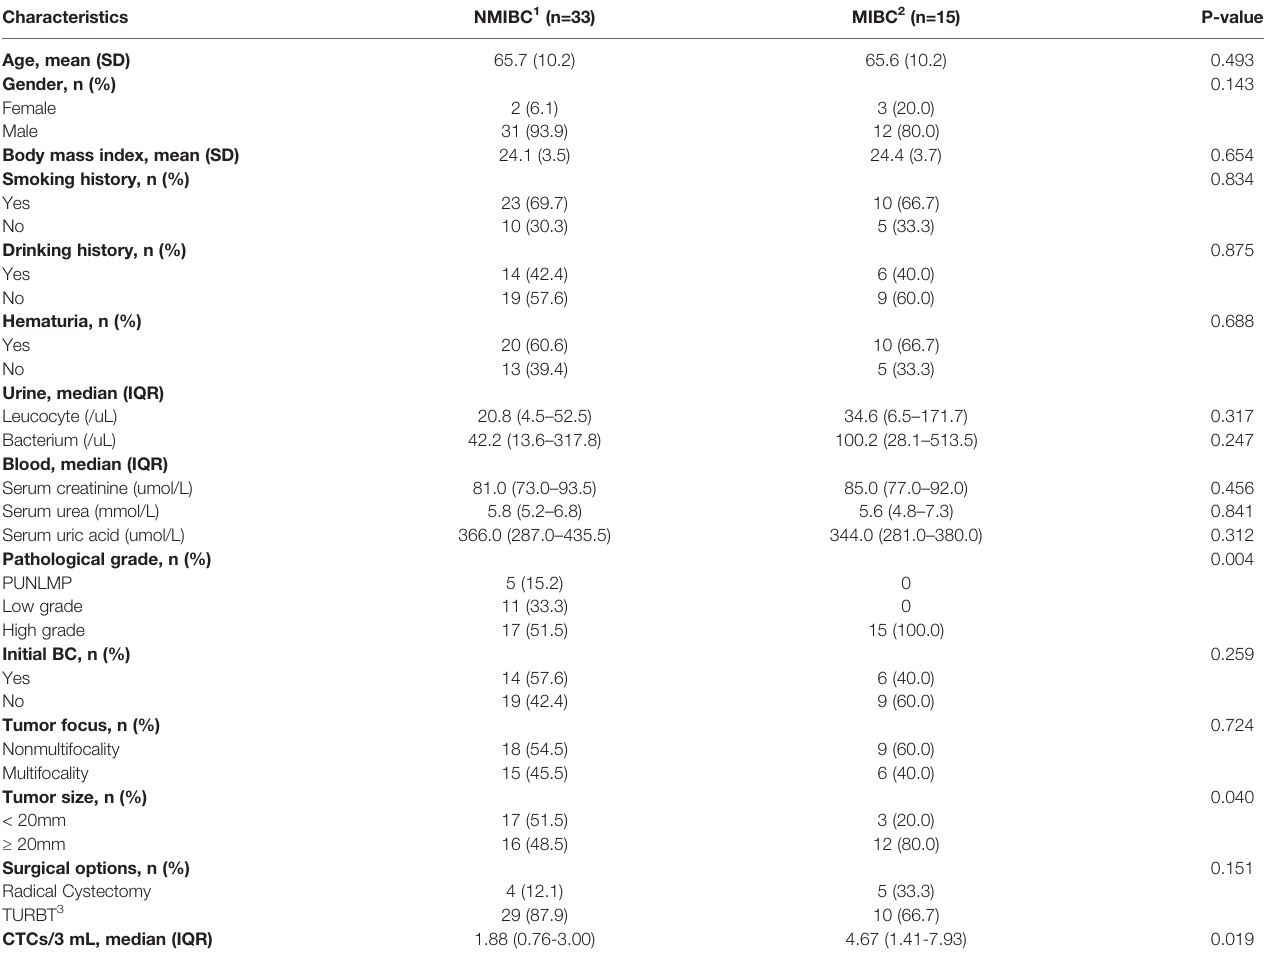
TABLE 1 | Baseline clinicopathological characteristics of the cohort.